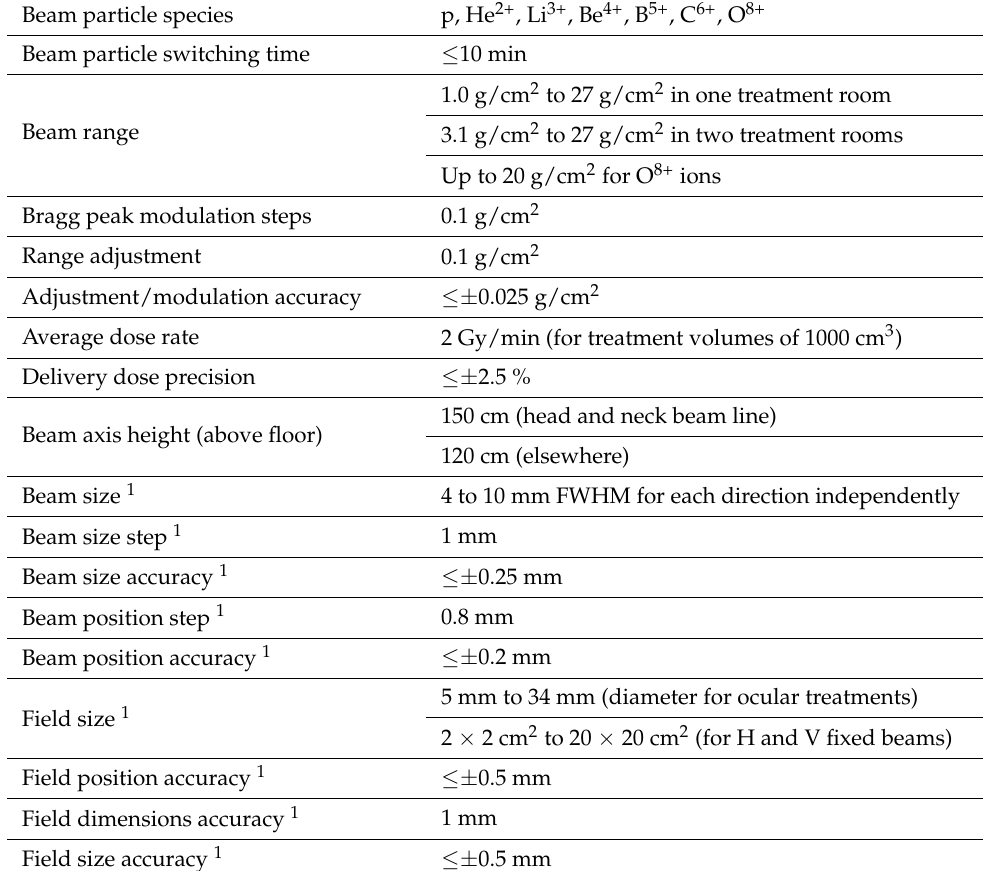
Table 1. Main specification of the CNAO hadron therapy